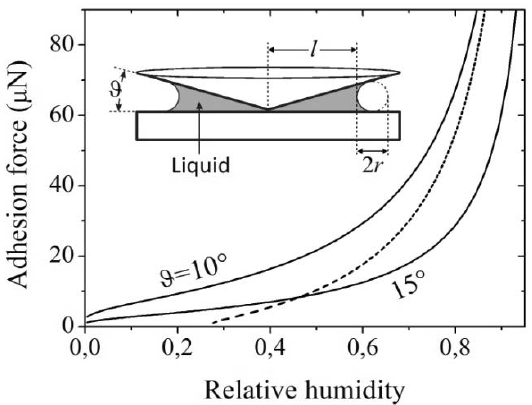
Fig. 1 Adhesion force caused by a capillary meniscus between a hydrophilic cone and a hydrophilic plate versus relative humidity. Results for two different conical angles are shown (continuous lines). The dashed line is the capillary adhesion force for a cone with ϑ = 10 (cid:155) but an asperity of 0.4 nm size at the very